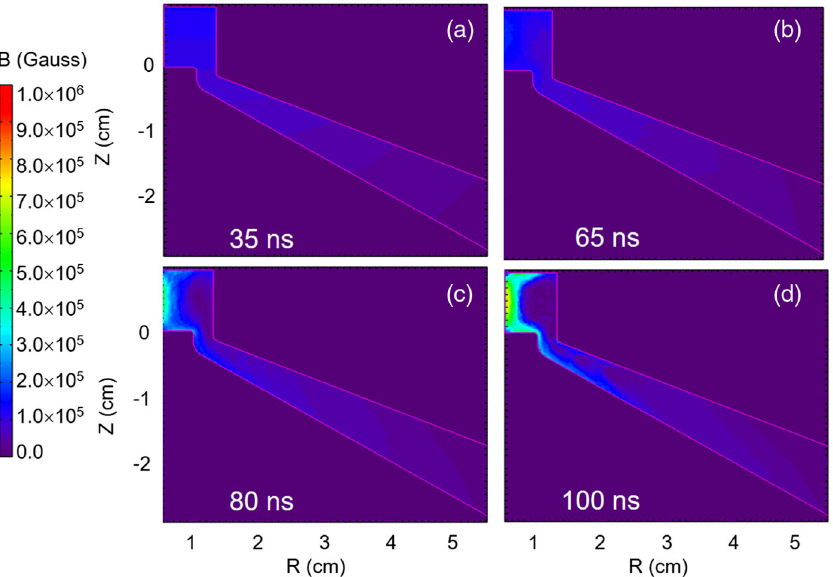
FIG. 13. The solenoidal field is plotted for the 10 − 5 Torr pressure with applied B field simulation at (a) 35, (b) 65, (c) 80, and (d) 100